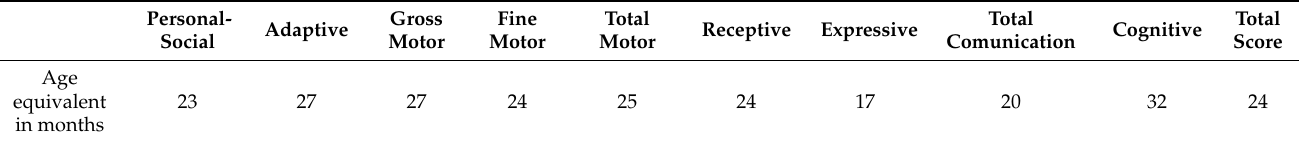
Table 2. Age equivalence by